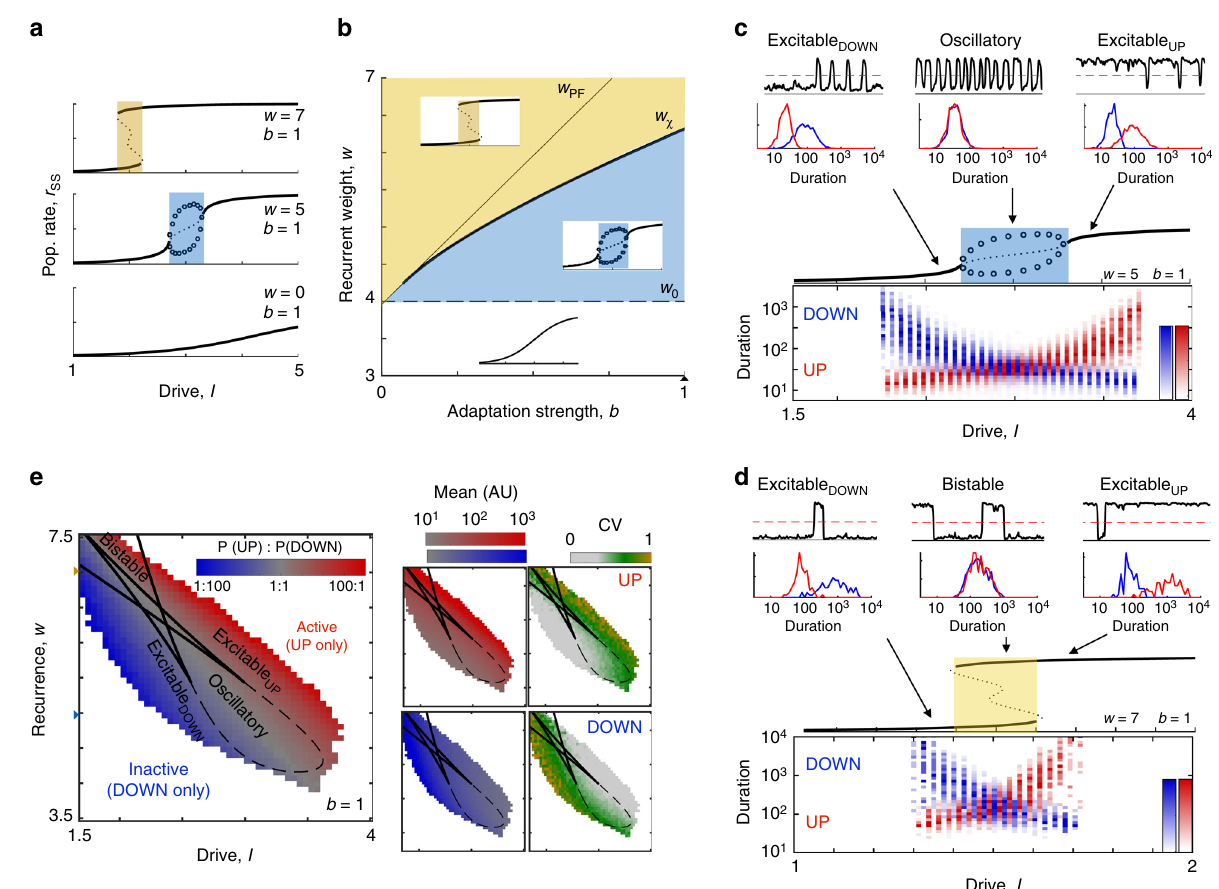
Fig. 3 Recurrence, adaptation, and drive determine dynamical regime and duration statistics. a Effective I/O curves for populations with increasing levels of recurrent excitation, w . Solid lines indicate stable fi xed points, dotted lines indicate unstable fi xed points, and circles indicate the upper/lower bounds of a limit cycle. Yellow indicates bistable regime (2 stable fi xed points), blue indicates oscillatory regime (0 stable fi xed points with a stable limit cycle). See also Supplementary Figs. 3 and 4. b Regions in the w - b parameter plane for distinct I/O properties, indicated by insets. Blue shading indicates parameter values for a oscillatory-centered I/O curve, yellow shading indicates a bistable-centered I/O curve. Boundary curves correspond to parameters where bifurcations vs I coalesce, see Supplementary Note 3. w PF : pitchfork bifurcation separating 5- fi xed point and 3- fi xed point (2 stable) regimes. w χ : degenerate pair of saddle node bifurcations, separating bistable-centered and oscillatory-centered I/O curves. w 0 : degenerate Hopf bifurcation separating oscillatory-centered and monotonic stable I/O curves. c Simulated duration distributions on the oscillatory-centered I/O curve. (Top) Simulated time course ( r vs t ) and dwell time distributions (bottom) for low ( I = 2.6), intermediate ( I = 3), and high ( I = 3.4) levels of drive. (Bottom) UP/DOWN state duration distributions as a function of drive to the system. Note logarithmic axis of duration. Color re fl ects observed proportion of UP/DOWN states with a given duration. d Same as c , for the bistable-centered I/O curve. e Duration statistics as a signature of UP/DOWN regime. (Left) Ratio of simulation time in UP and DOWN state. (Right) Mean and CV of simulated dwell times for UP and DOWN states in the I-W parameter space with fi xed b (triangle in